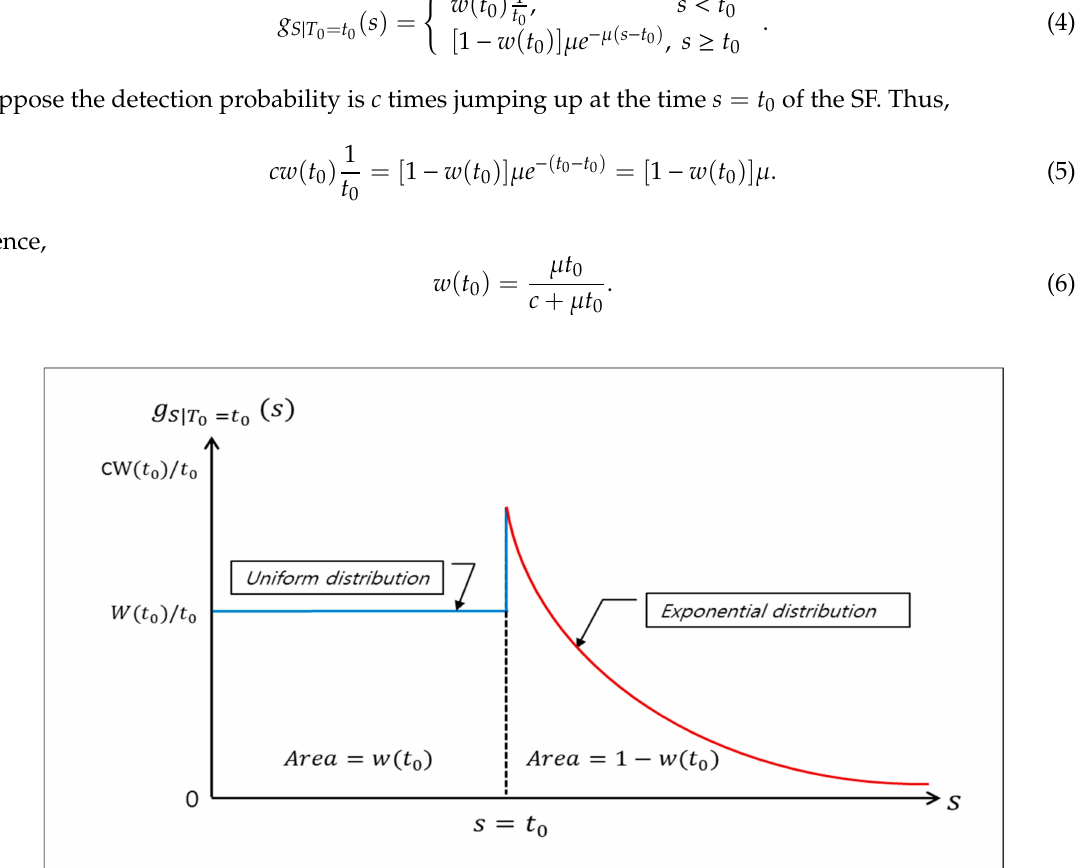
( s ) , conditioned by the SF time T 0 = t 0